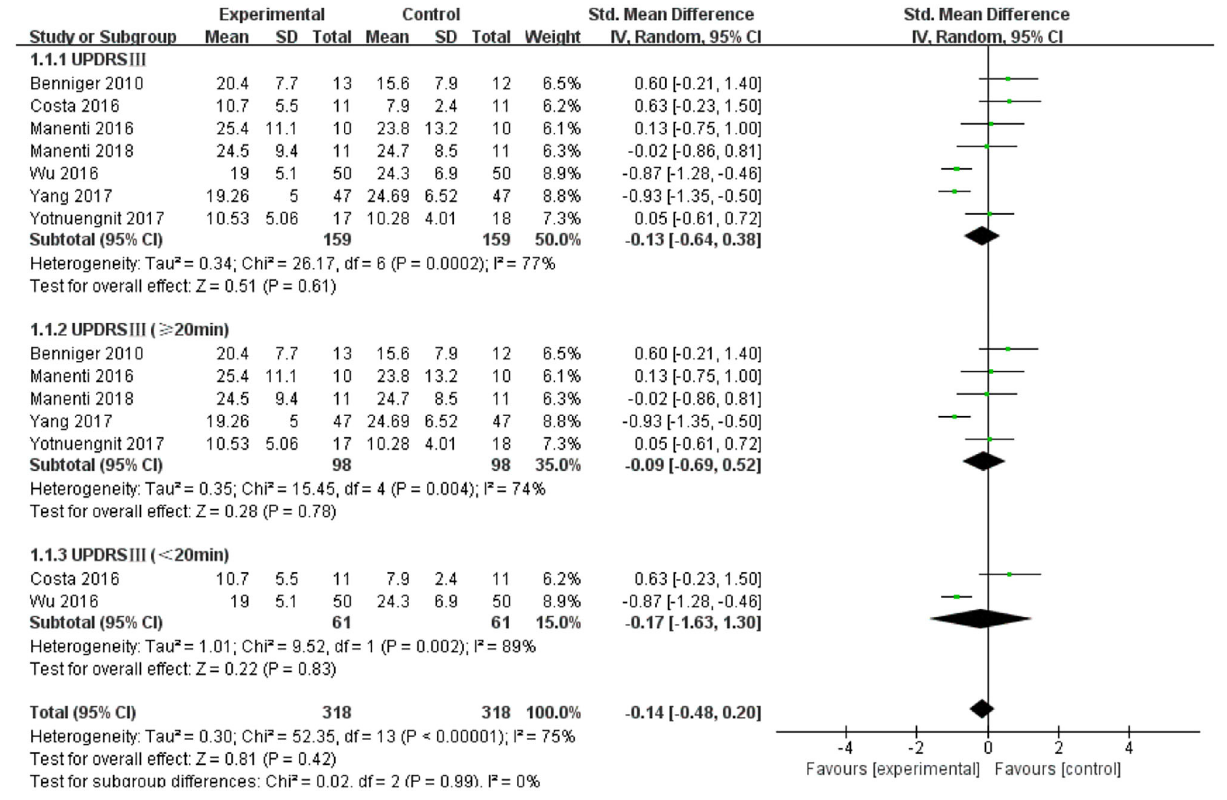
FIGURE 4 | Effects of tDCS on the UPDRS III scores in patients with PD. Comparison between subgroups of tDCS duration. CI, confidence intervals; PD, Parkinson’s disease; SD, standard deviation; tDCS, transcranial direct current stimulation; UPDRS, Unified Parkinson’s Disease Rating